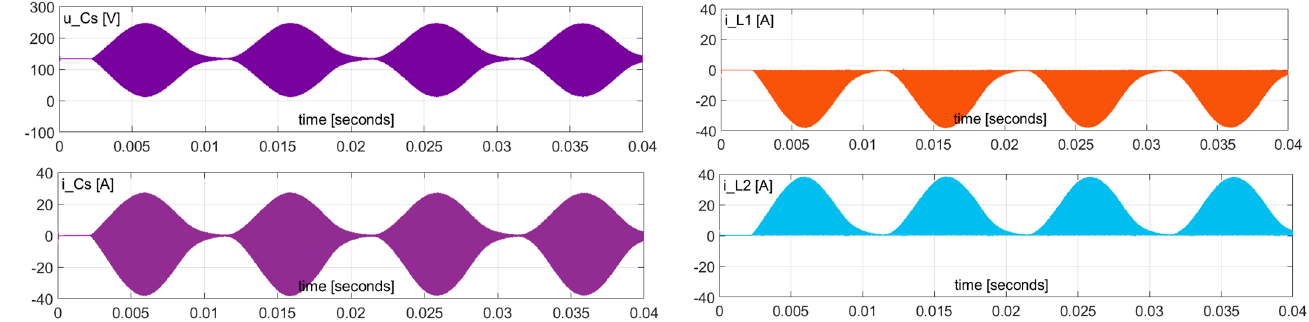
Figure 8. Steady state waveforms of DC-AC system with the AIVB operating with constant frequency. 25 us/div, P out = 1 kW, L f = 6 uH.